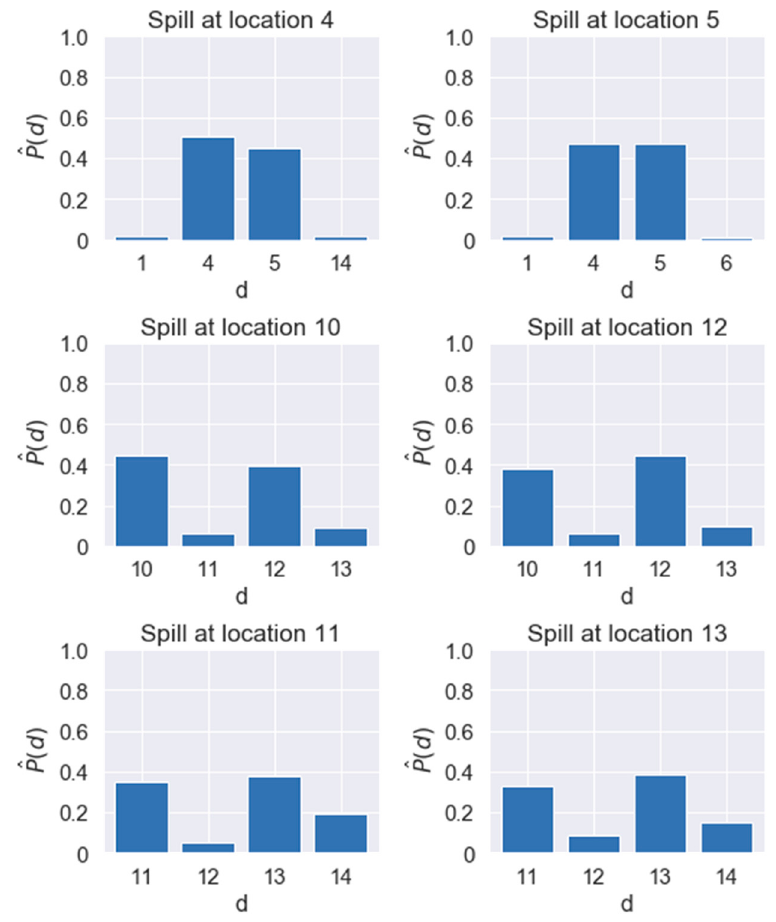
ˆ P ( d ) values for some related pairs of spill Figure 9. Examples of 𝑃(cid:3552)(𝑑) values for some related pairs of spill locations. Figure 9. Examples of